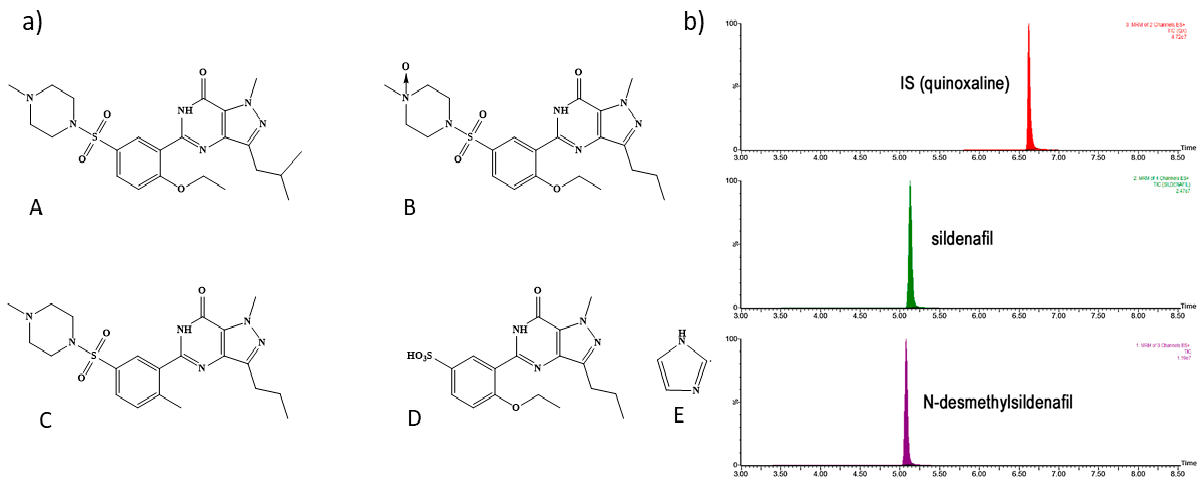
Figure 4. ( a ) Chemical structure of sildenafil impurities A, B, C, D and E.; ( b ) MRM chromatogram of N-desmethylsildenafil, sildenafil and quinoxaline (internal standard) adopted with permission from [30]. 2015